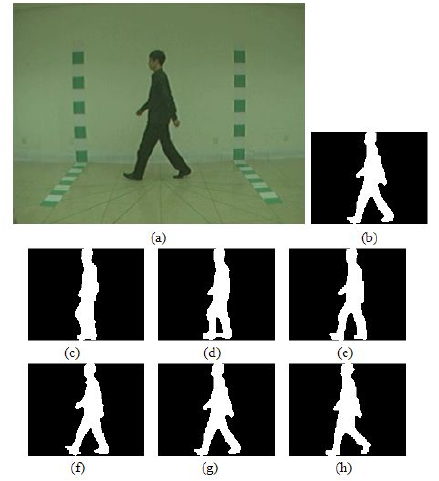
Fig. 2. An example of silhouette segmentation: (a) an orig- inal image in gait database, (b) the normalized and aligned silhouette of (b), (c)-(h) temporal changes of six successive frames in a gait silhouette sequence.